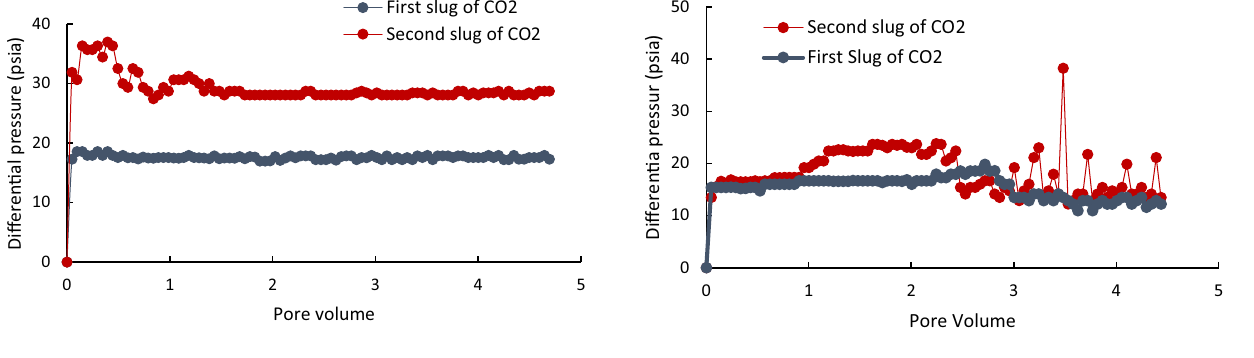
2 slug before and after blended